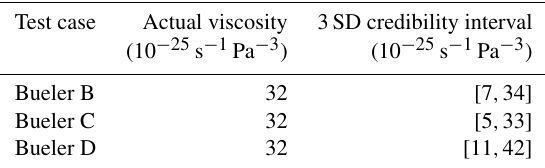
Table 2. Ice viscosity posterior intervals.